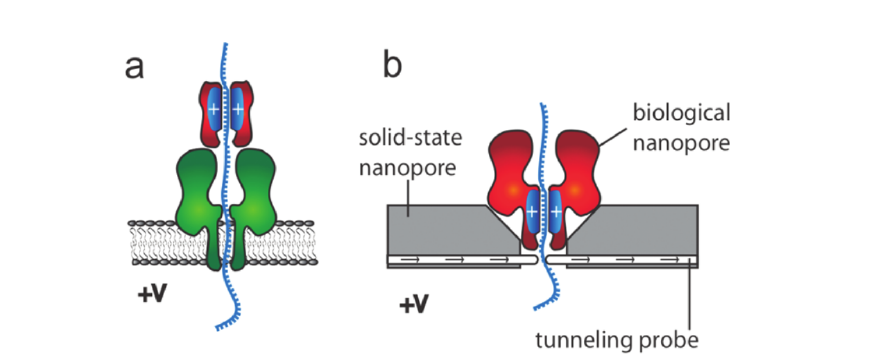
Figure 6. Nanopores with molecular brakes; ( a ) shows a protein nanopore with a synthetic protein barrel which is positively charged, whereas ( b ) shows a hybrid nanopore where the protein channel contains an internal positive charge. Reprinted with permission from [197] copyright 2016 by American Chemical Society.